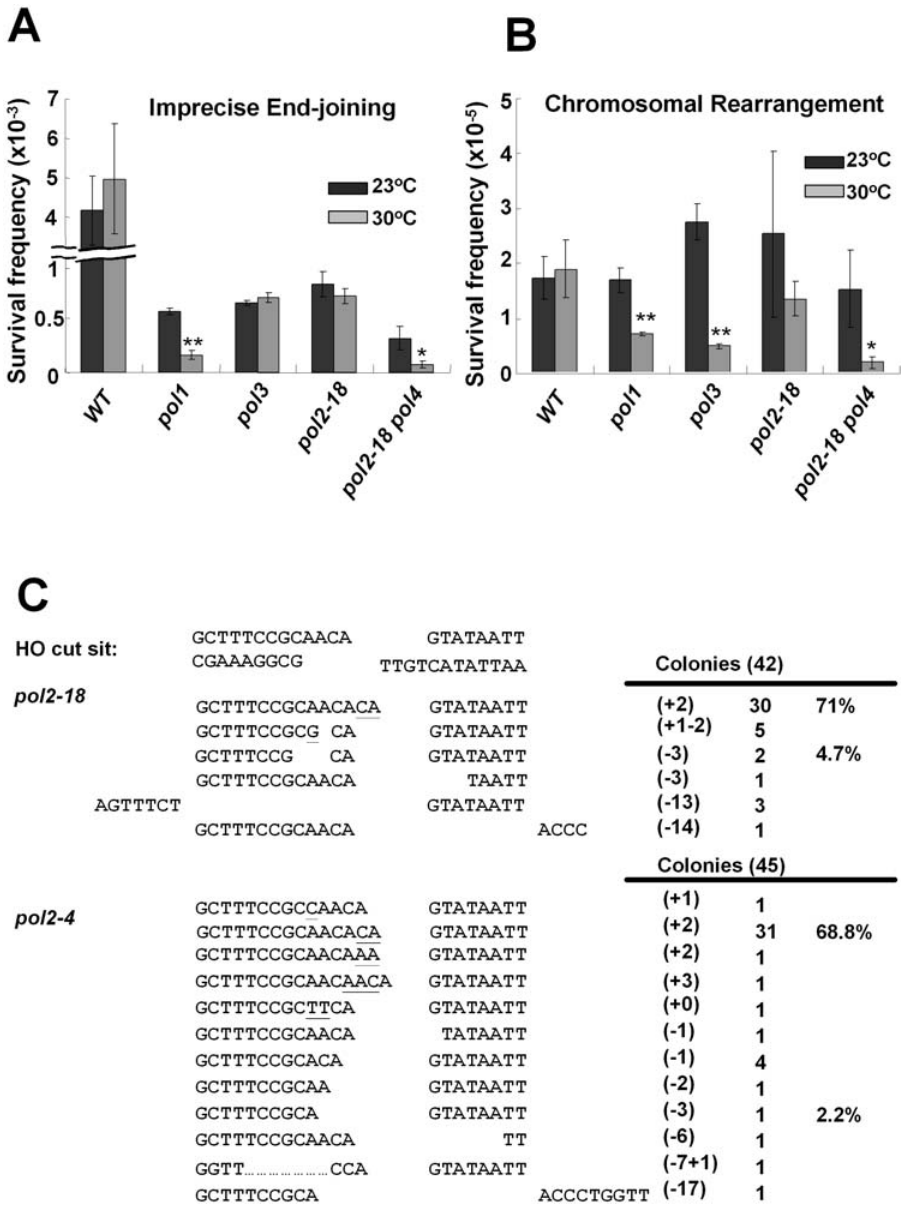
Figure 3. Measurements of NHEJ ability of essential DNA polymerases. The NHEJ assay was performed for pol1 , pol3 , pol2-18 and pol2-18 pol4 at permissive (23 u C) and semi-permissive (30 u C) temperatures. (A) Frequencies of imprecise end joining. The survival frequency was evaluated by the ratio of YPGal/YPD. (B) Frequency of chromosomal rearrangement was evaluated by the ratio of FOA R /YPD. Each experiment was collected from at least five independent clones. Dark gray bars indicate 23 u C incubation and light gray bars indicate 30 u C incubation. *: P , 0.05; **: P , 0.01. (C) Survivors of pol2-18 or pol2-4 mutants from YPGal plates at 30 u C were examined. Bases underlined indicate insertion or mutation. The numbers of inserted ( + ) and deleted ( 2 ) bases were denoted in brackets. N indicates the events of each repair pattern.